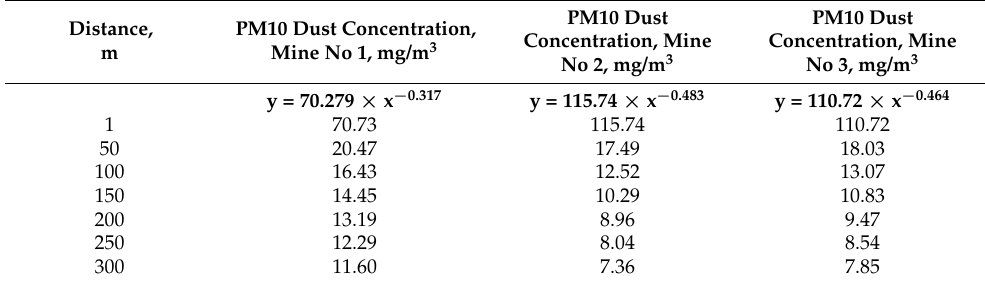
Table 1. Dust concentration measurements in the gates, extrapolated to a distance of 300 m from the dust source.